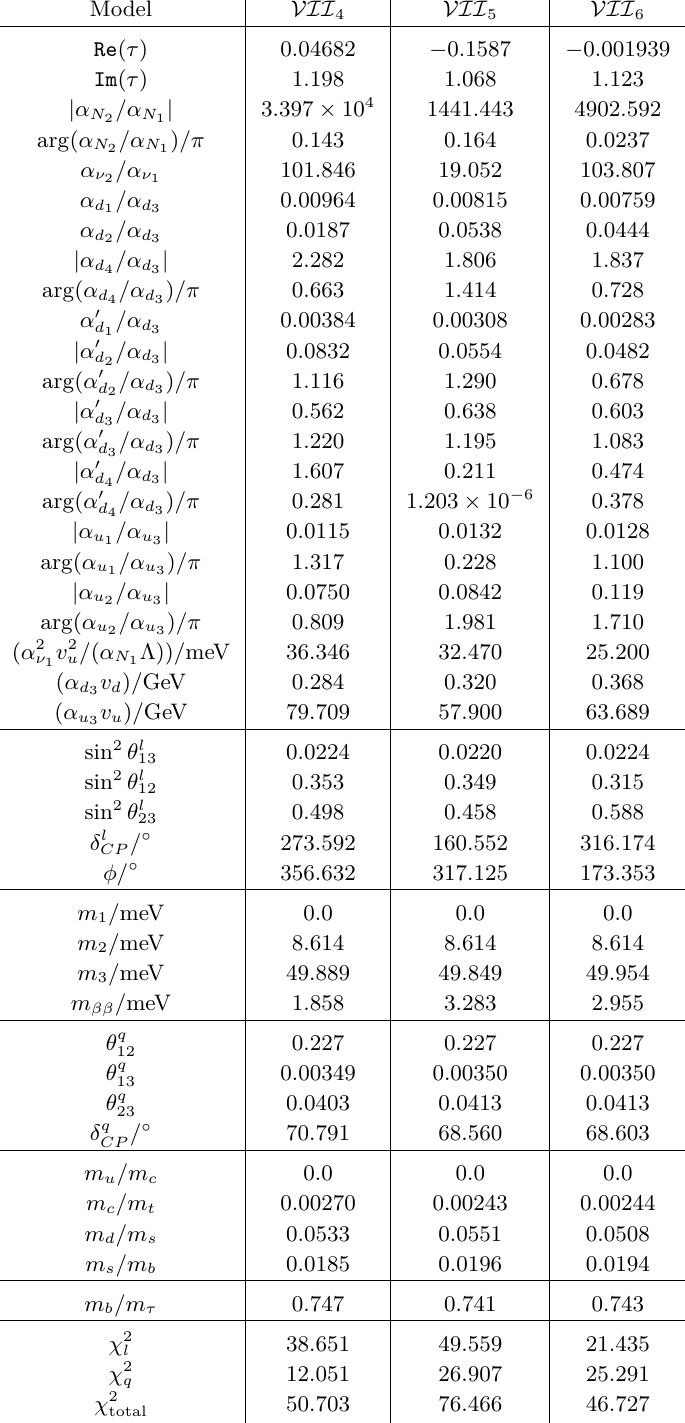
Table 16 . The best fit values of the free parameters and the corresponding predictions for lepton and quark mixing parameters and fermion masses for the phenomenologically viable models of Type-VII (continuation of table